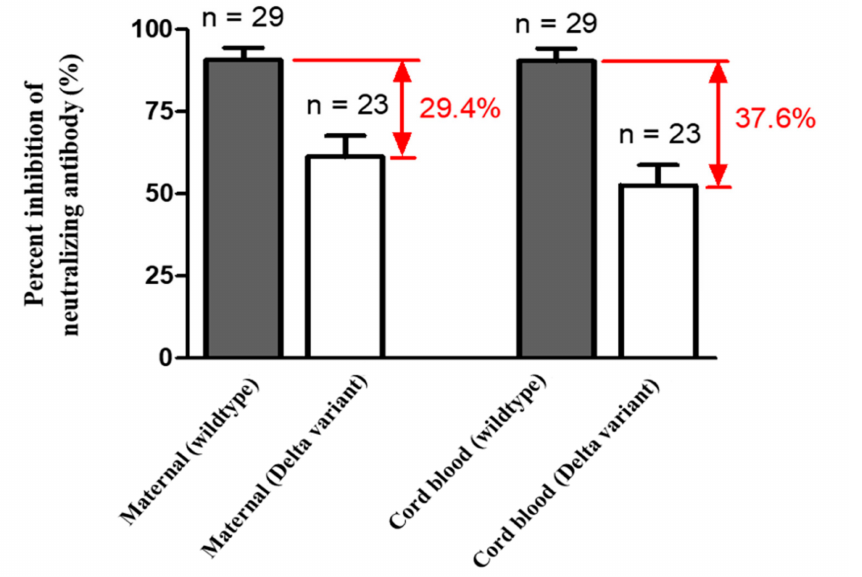
Figure 1. Mean percent inhibition of neutralizing antibodies in maternal and cord blood (wildtype n = 29 with two dose n = 25, one dose n = 4; Delta variant n = 23 with two dose n = 19, one dose n = 4; p value of maternal (wildtype) versus maternal (Delta variant) = 0.0001; p value of cord blood (wildtype) versus cord blood (Delta variant)